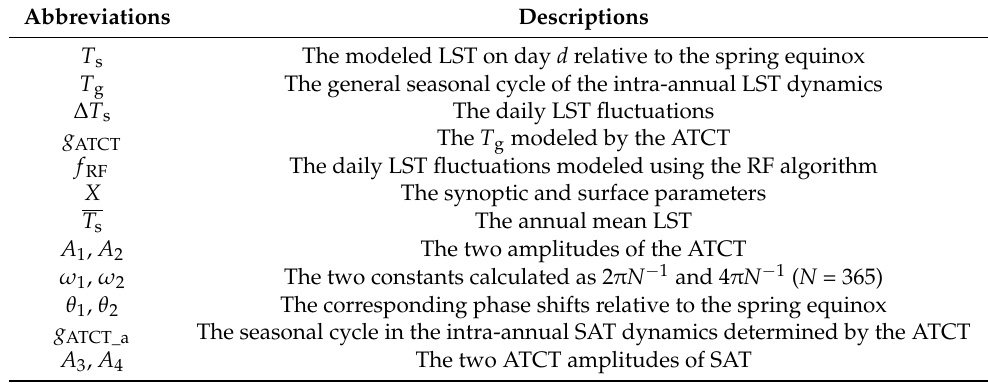
Table 3. All the mathematical symbols and their meaning in the following